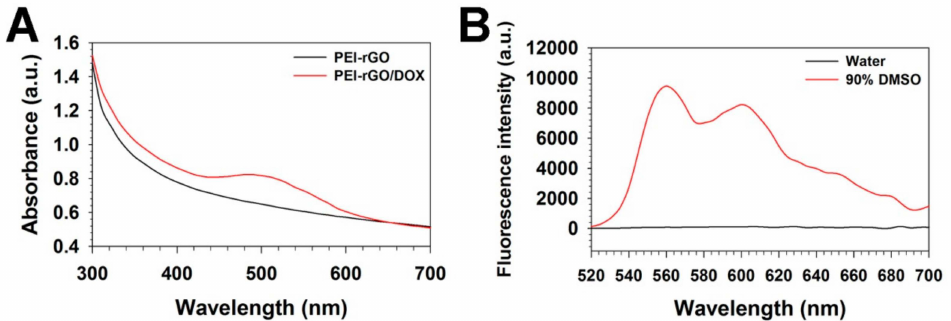
Figure 3. ( A ) Absorbance spectra of PEI-rGO (black) and PEI-rGO / DOX (red). ( B ) Fluorescence spectra of PEI-rGO / DOX in water (black) and 90% DMSO (red).